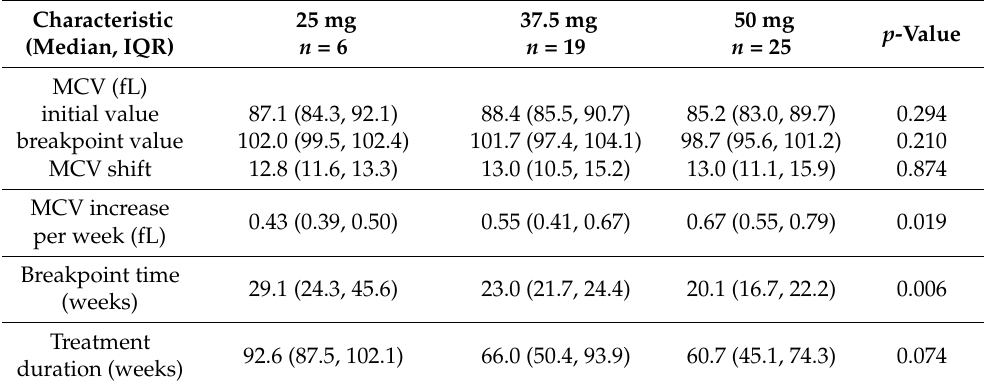
Table 3. Observed parameters of MCV time-courses and sunitinib dose-related effect in the group of full periods.